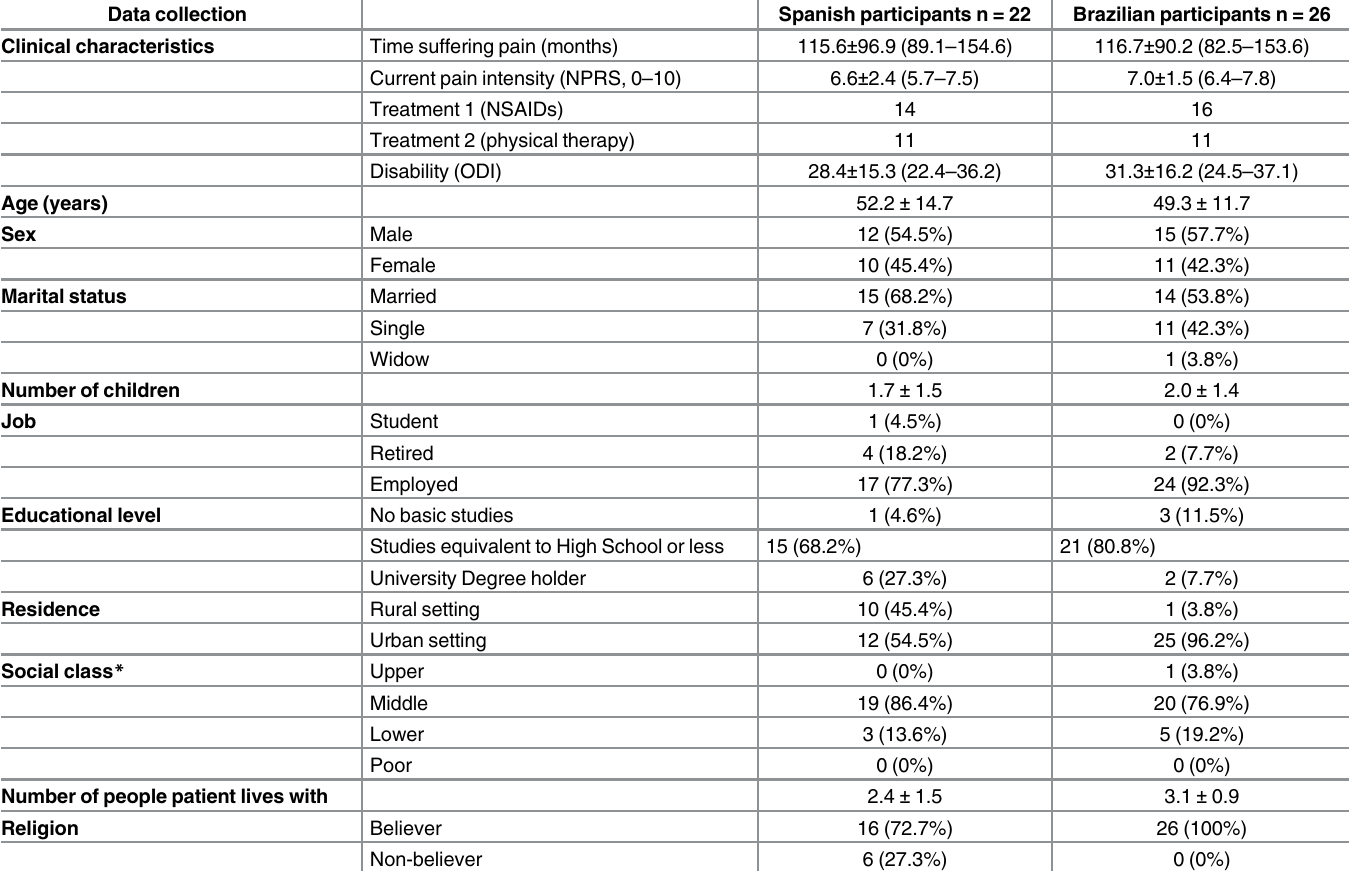
Table 3. Sociodemographic